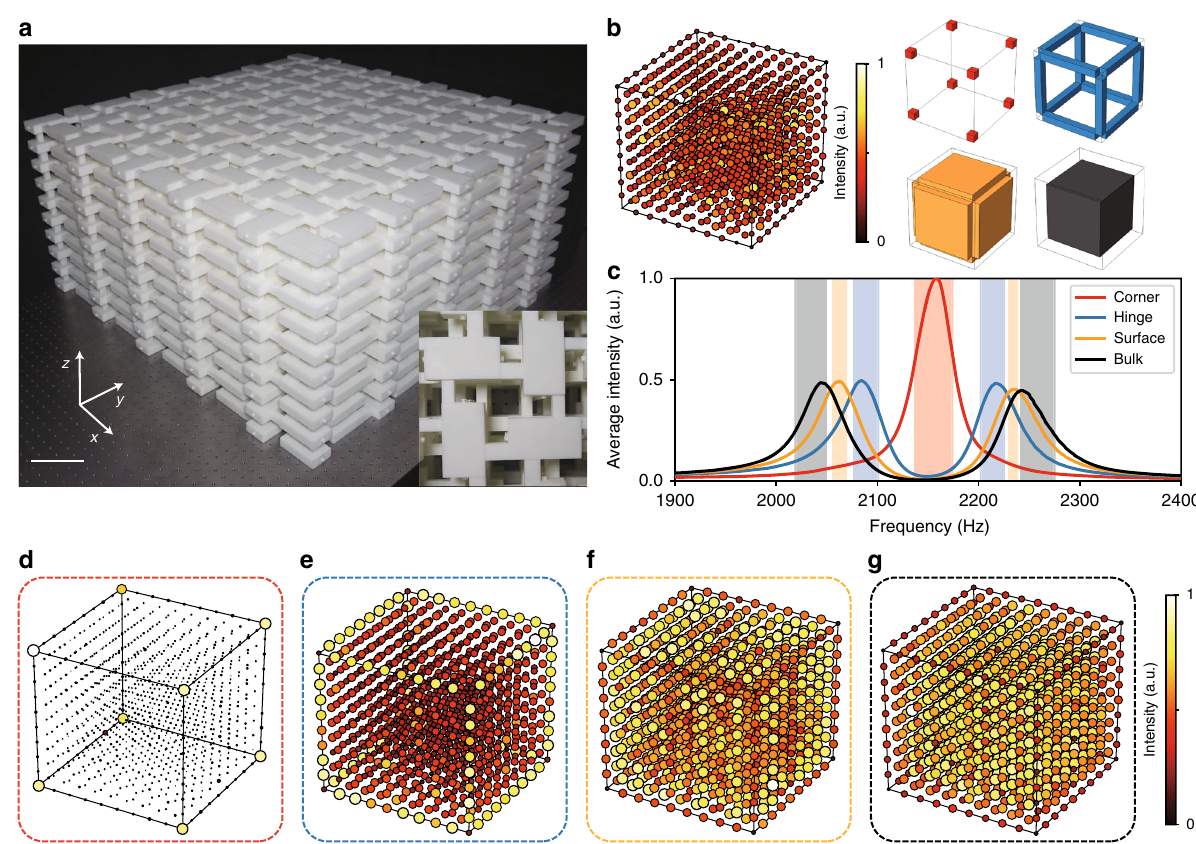
Fig. 3 Experimental demonstration of an acoustic octupole topological insulator. a Photo of the fabricated sample with fi ve unit cells along each direction. The scale bar is 100 mm. b Left panel: measured sound intensity of all sites at an arbitrarily chosen frequency (2000 Hz). Right panel: illustration of the four regions (corner, hinge, surface and bulk) used to calculate the average intensity spectra. c Measured average intensity spectra for a fi nite lattice in the topological phase. d – g Spatial distributions of the acoustic response intensity, integrated over different sets of frequencies corresponding to the corner ( d ), hinge ( e ), surface ( f ) and bulk ( g ) spectra; the frequency ranges are indicated by the corresponding coloured regions in c